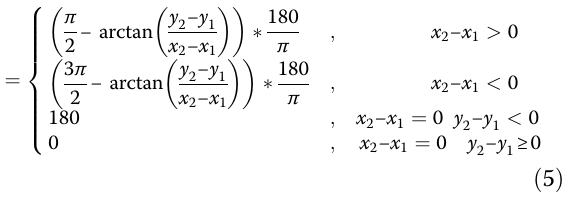
and c 2 , respect- 1 1